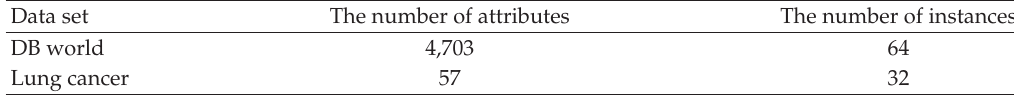
Table 11: The number of attributes and instances of data sets.